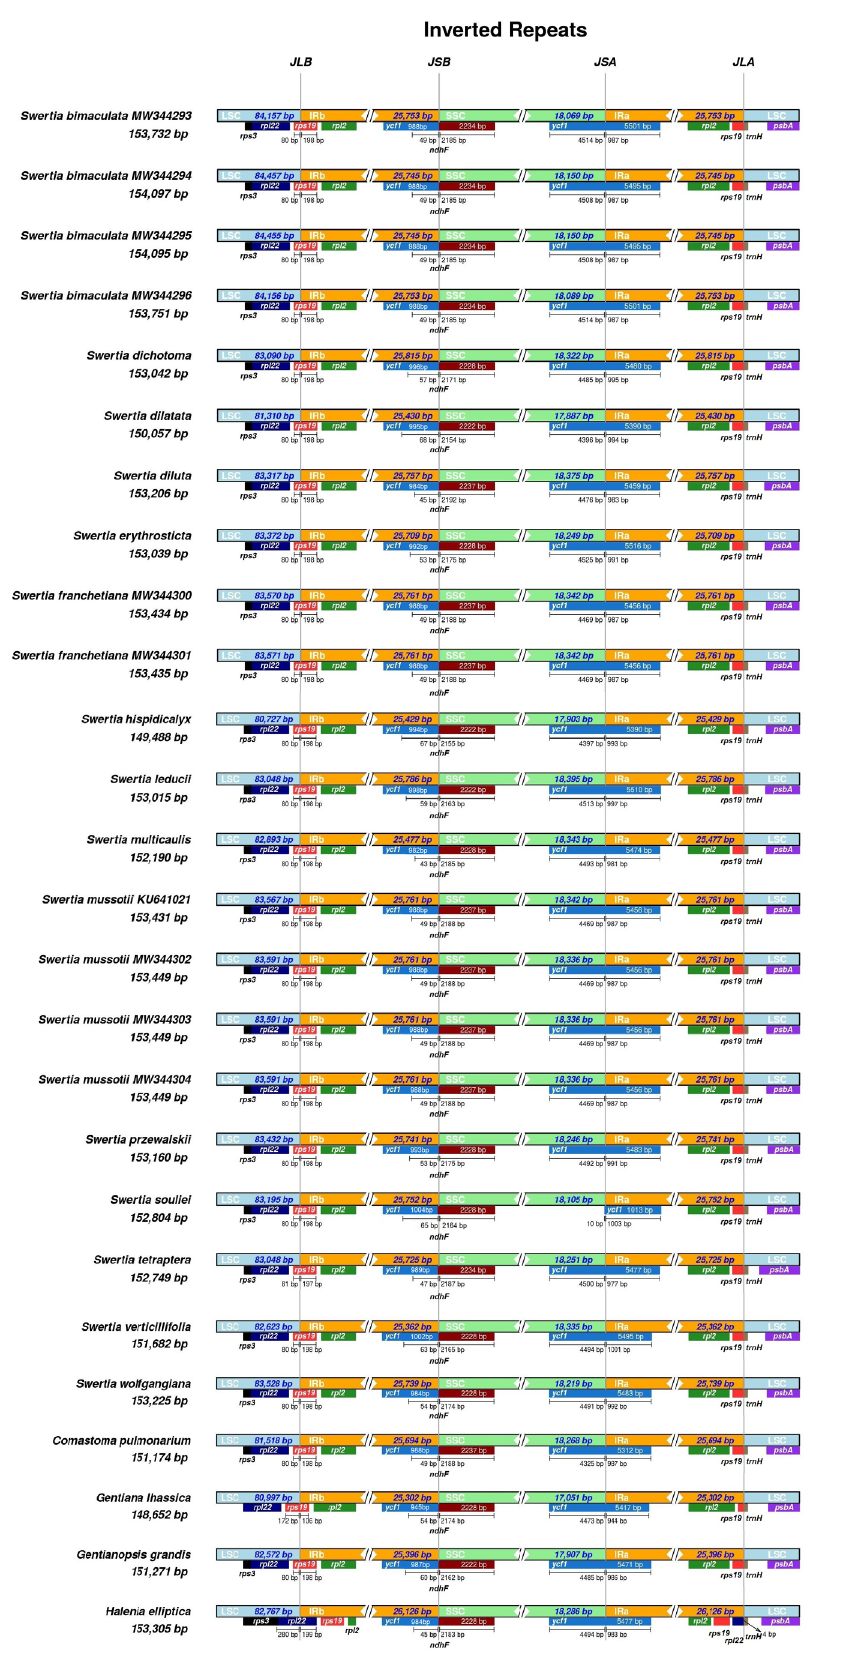
Figure 3 – Boundaries of the LSC, SSC, and IRs in chloroplast genomes of 15 Swertia and four related species. LSC: large single copy region; SSC: small single copy region; IRa and IRb: two inverted repeat regions; JLB: junction between the LSC and IRb; JSB: junction between the SSC and IRb; JSA: junction between the SSC and IRa; JLA: junction between the LSC and